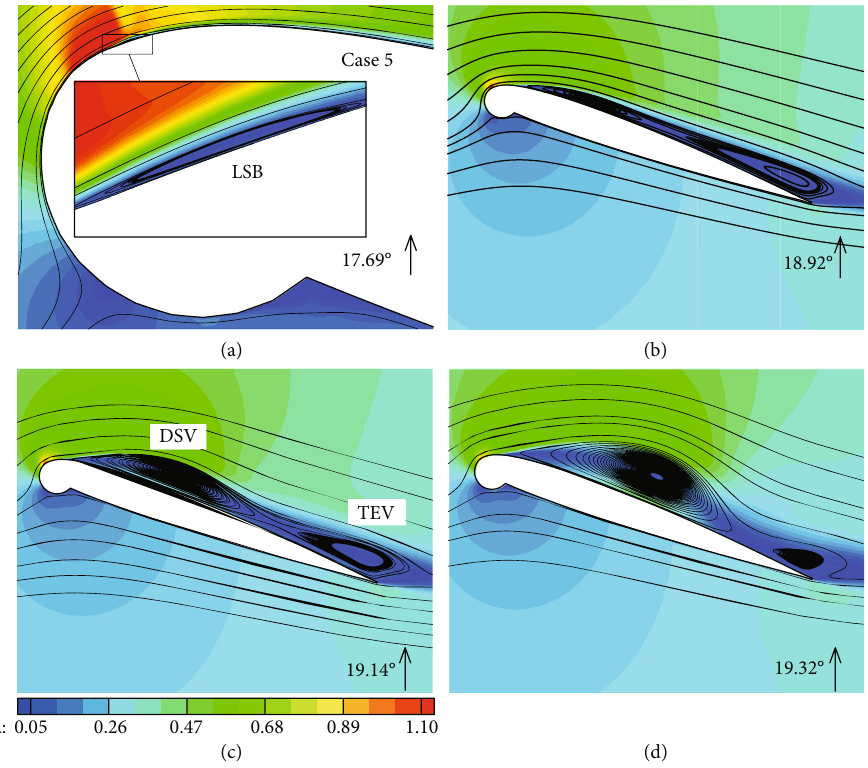
Figure 27: Streamlines and Mach number contours in Case 5 at di ff erent angles of